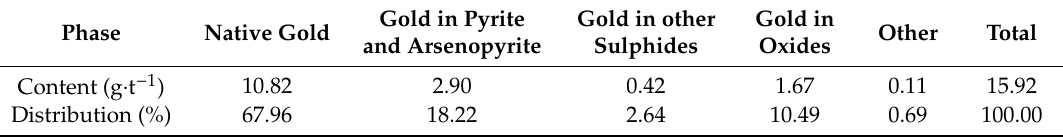
Table 3. Chemical phase analysis of gold in ore.